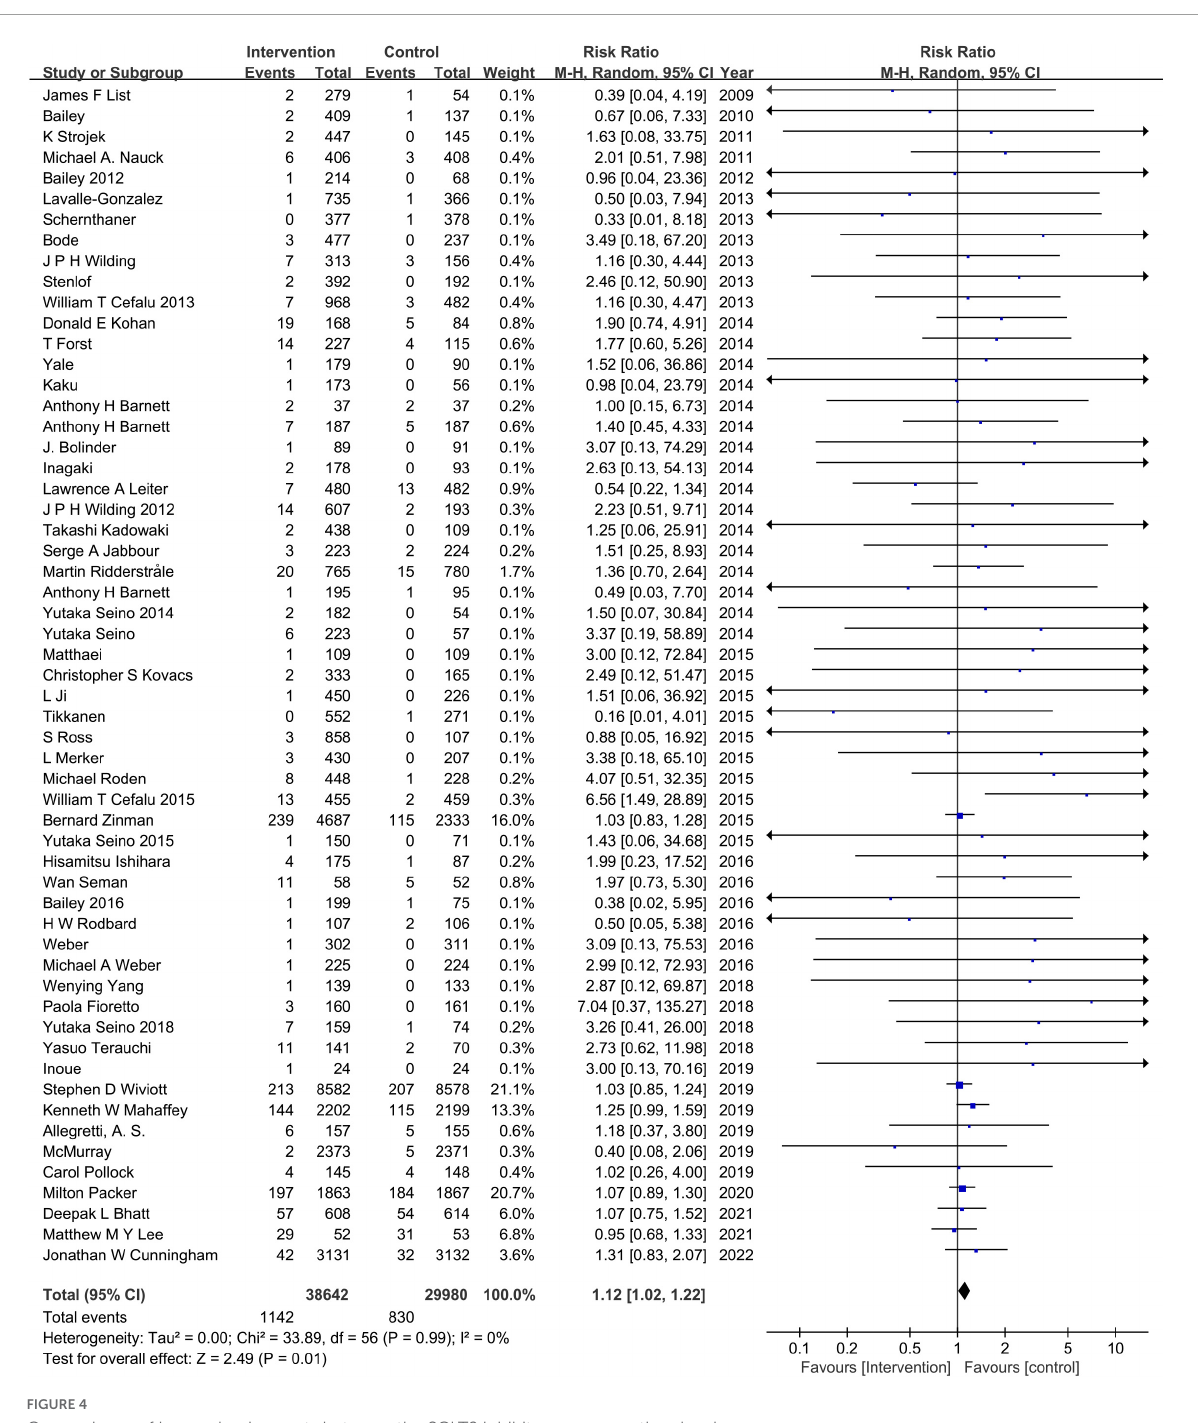
FIGURE4 Comparisons of hypovolemia events between the SGLT2 inhibitors group vs. the placebo group.